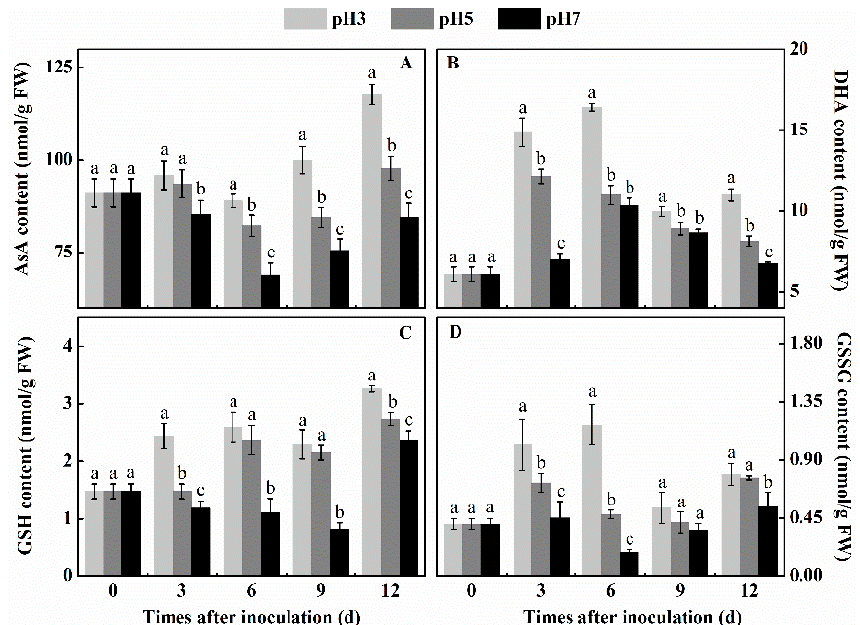
Figure 6. Effect of inoculation of T. roseum at different pH conditions on the activity of AsA ( A ), DHA ( B ), GSH ( C ), and GSSG ( D ) of colonized apple fruits. Bars indicate standard error (±SE). Different letters indicate statistically significant differences ( p < 0.05) among treatments.